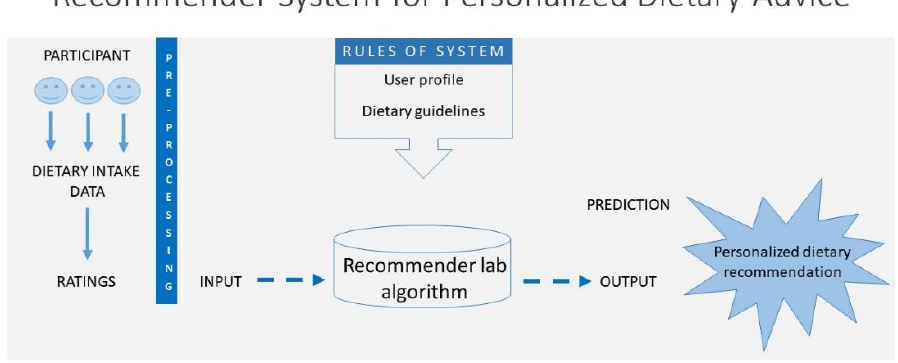
Figure 1. The architecture of the dietary recommender system for ELSA-Brasil study participants.